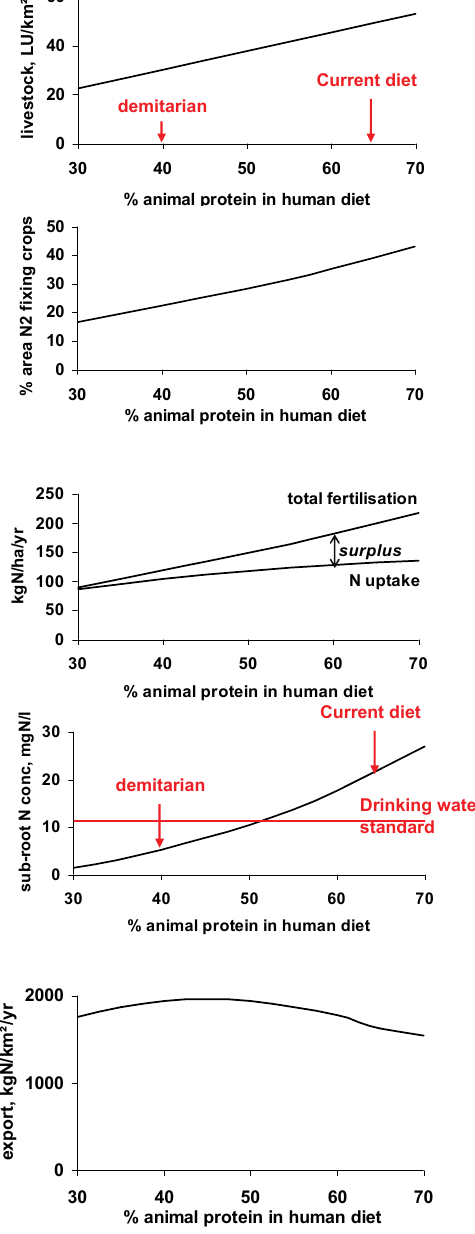
Fig. 5. Effect of reducing the proportion of animal-based protein in the human diet on the N fluxes through the agricultural system in an organic, local scenario of the Seine watershed.